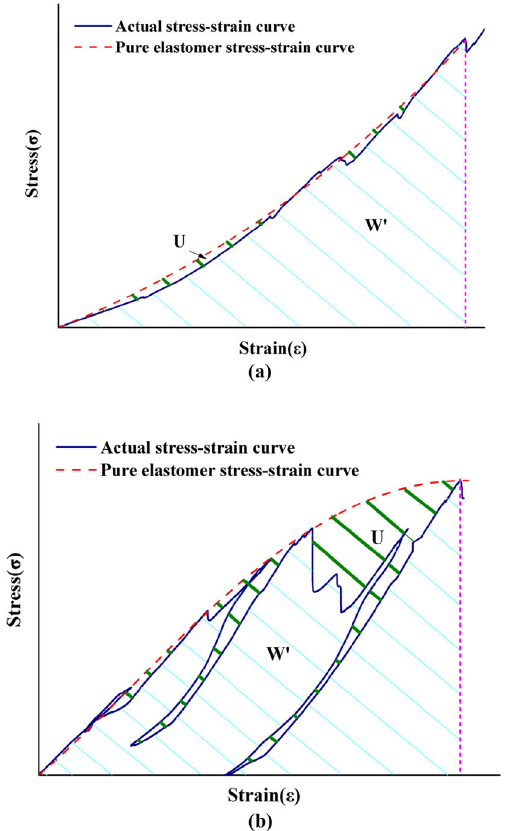
Fig. 7 A typical model of energy evolution. a Grade loading. b CYCLIC